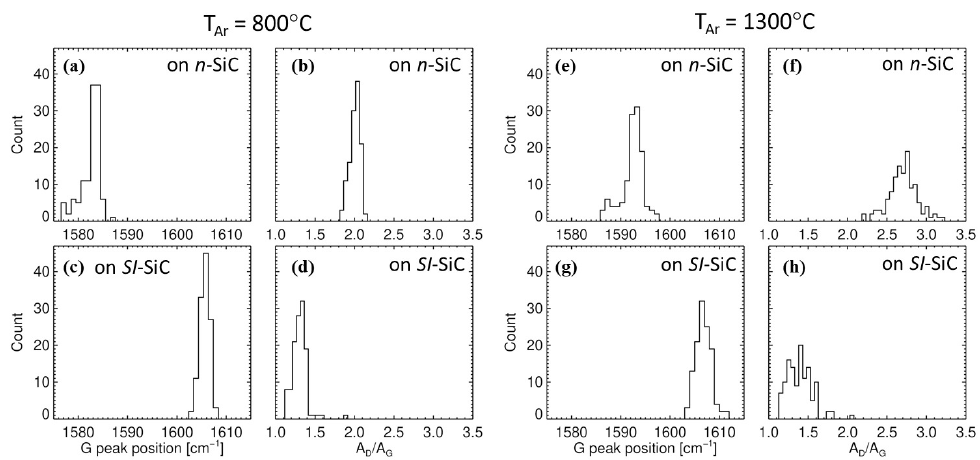
Figure 6. Histograms of the G BL band position and the ratio of the D BL and G BL band areas, A D / A G , for the buffer layers grown with T Ar = 800 ◦ C ( a – d ) on n -type ( a , b ) and SI (c,d) 4H– BL BL SiC; and for the buffer layers grown with T Ar = 1300 ◦ C ( e – h ) on n -type ( e , f ) and SI ( g , h ) 4H–SiC. The histograms are obtained over Raman maps of 3 µ m × 3 µ m. Three Lorentzian lineshapes centered around G BL of 1585–1600 cm − 1 , D BL of 1330–1530 cm − 1 and a band centered at 1340 cm − 1 were used for the